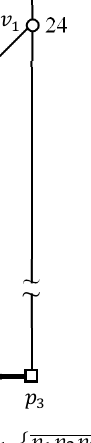
Figure 7. maxdist ( v 1 , { p 1 p 2 p 3 } ) = 24 and mindist ( v 1 , { p 1 p 2 p 3 } ) =